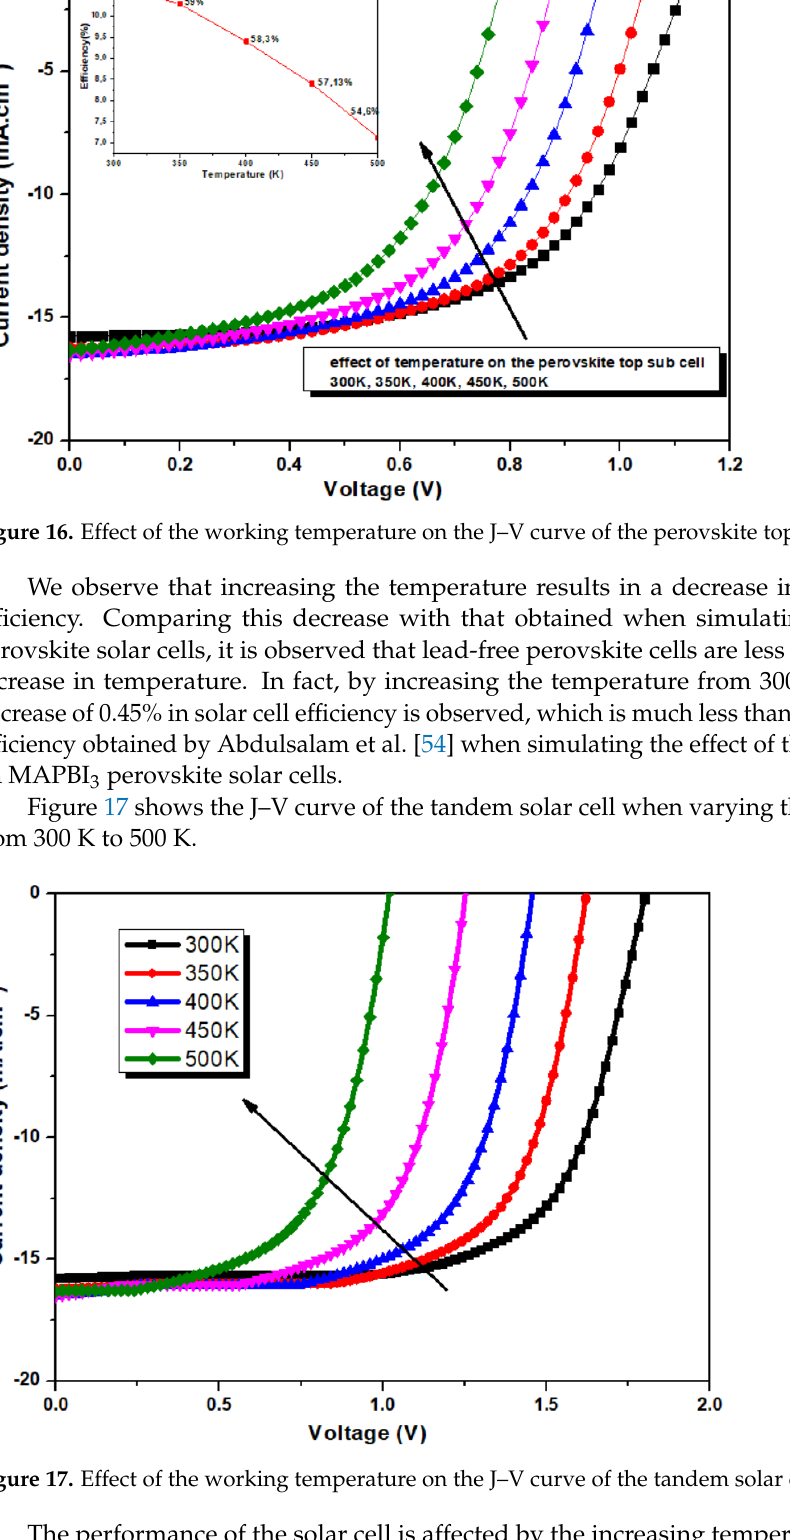
The performance of the solar cell is affected by the increasing temperature, which is linked to open-circuit voltage decay. V oc is reduced because of its direct link to reverse saturation current density (J o ), which is further related to intrinsic carrier concentration